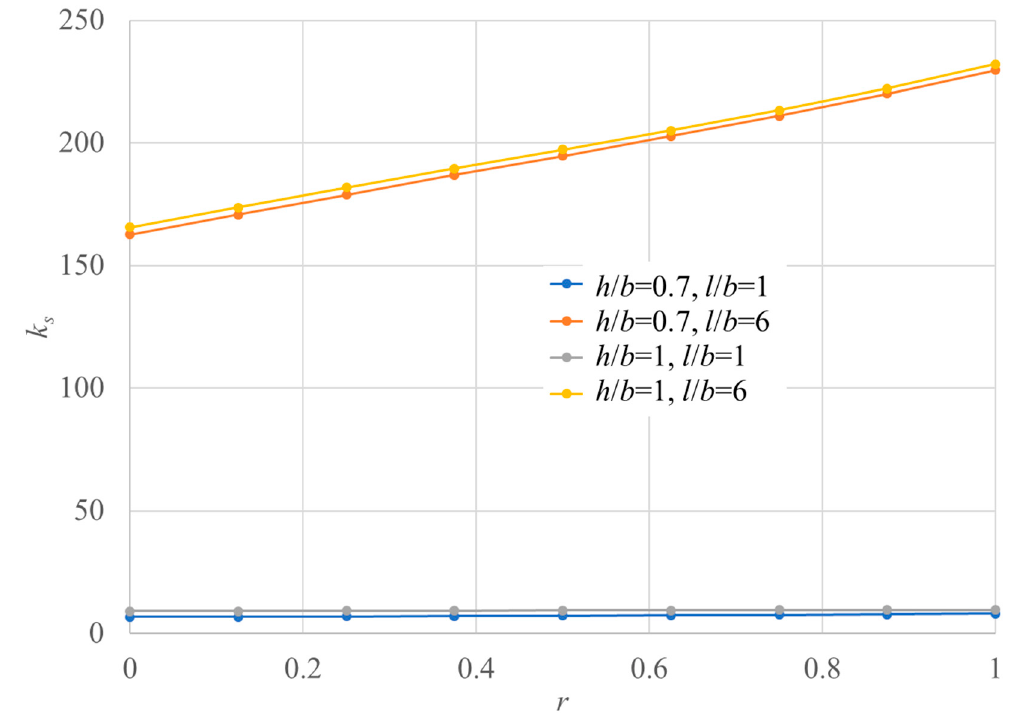
Figure 9. k s versus r .